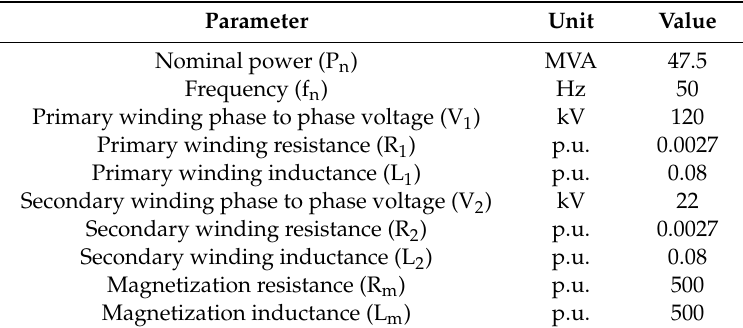
Table A1. Distribution transformer parameters.